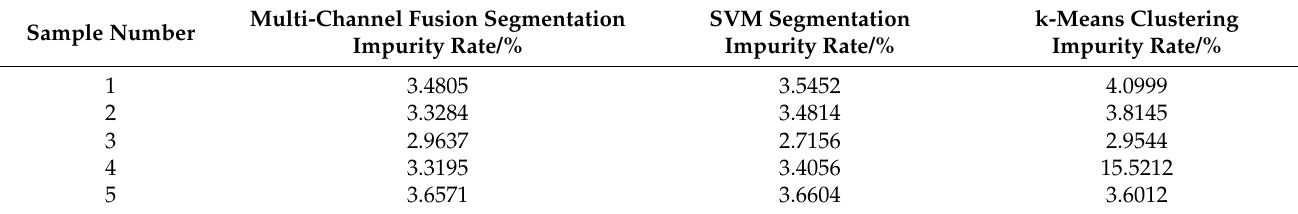
Table 1. Impurity contents of machine-picked seed cotton based on image